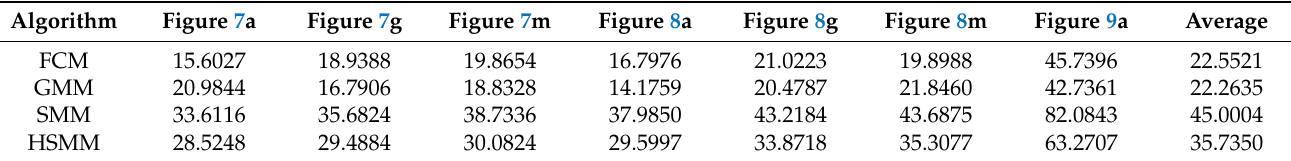
Table 5. Efficiency performance of the different segmentation algorithms.